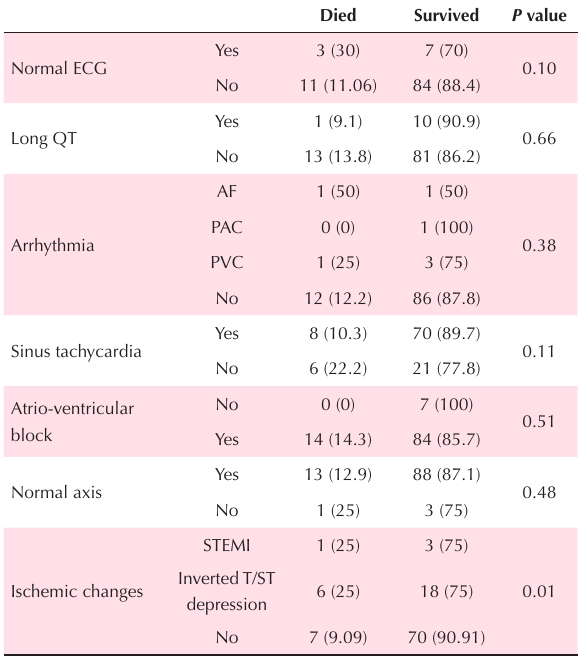
Table 2. Comparison of ECG parameters in died and survived cases